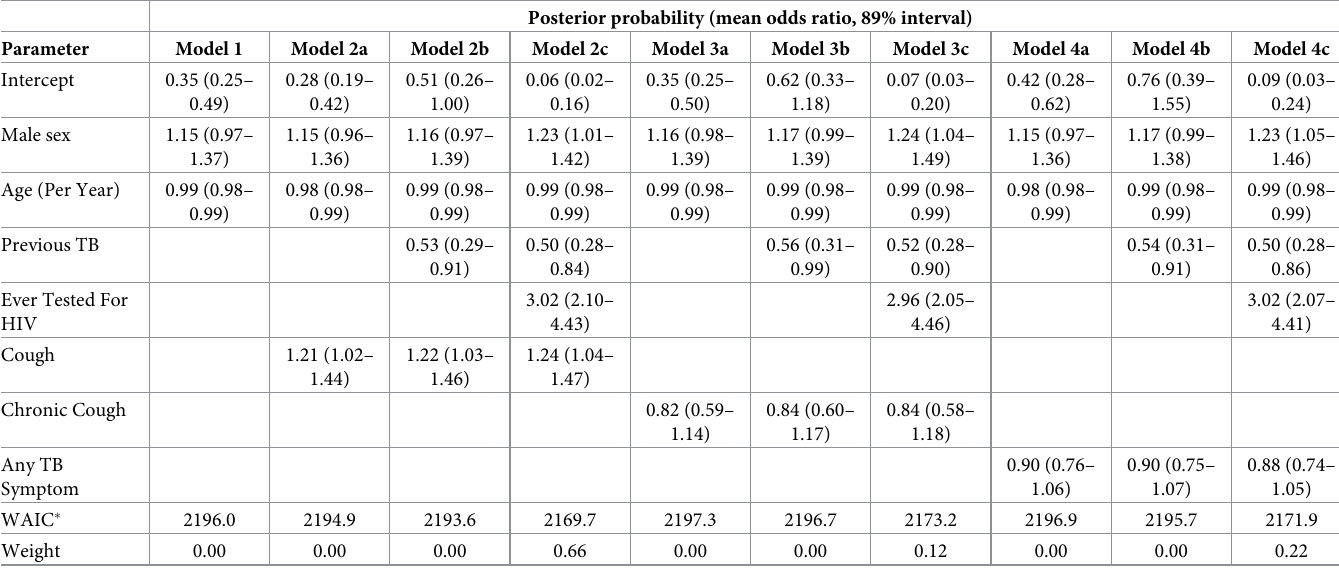
Table 2. Model posterior probabilities of completing HIV testing during clinic